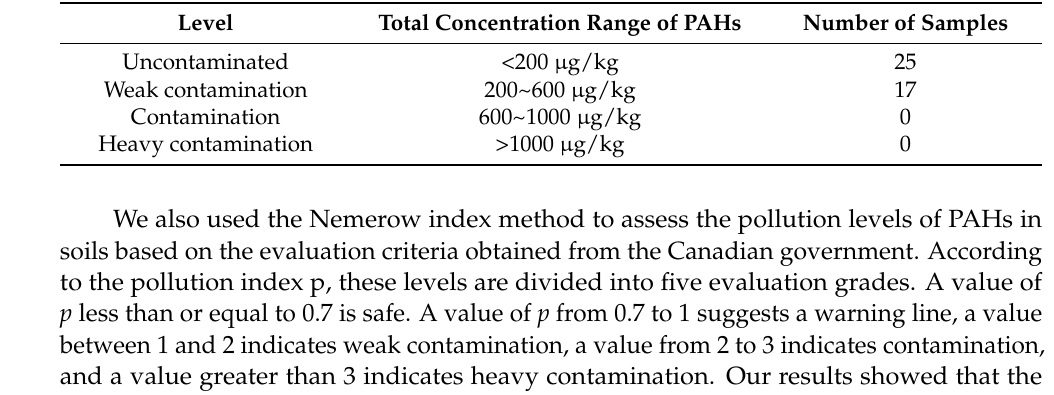
Table 4. Evaluation standard for the total pollution levels of PAHs.